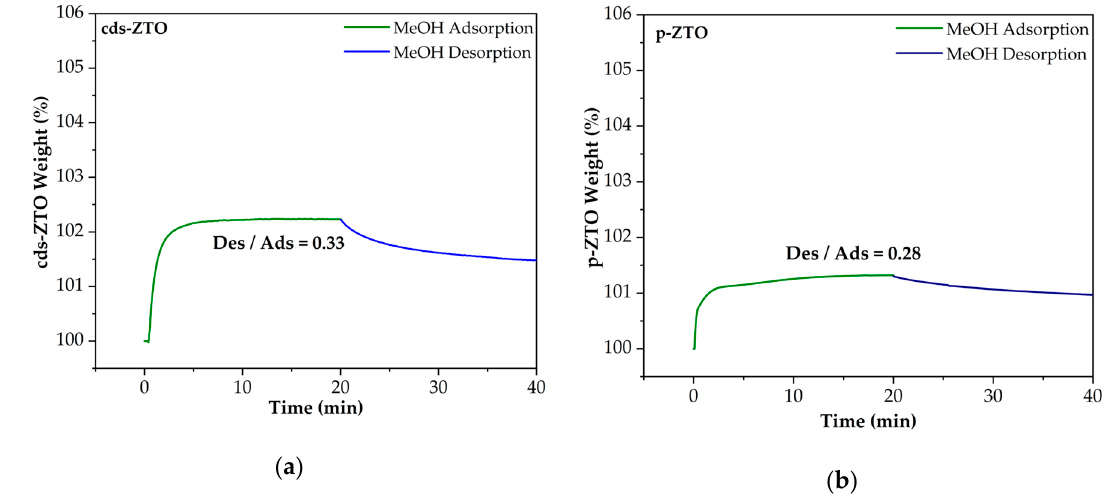
Figure 11. Adsorption–desorption isotherms of MeOH on ( a ) cds-ZTO, (b ) p-ZTO.